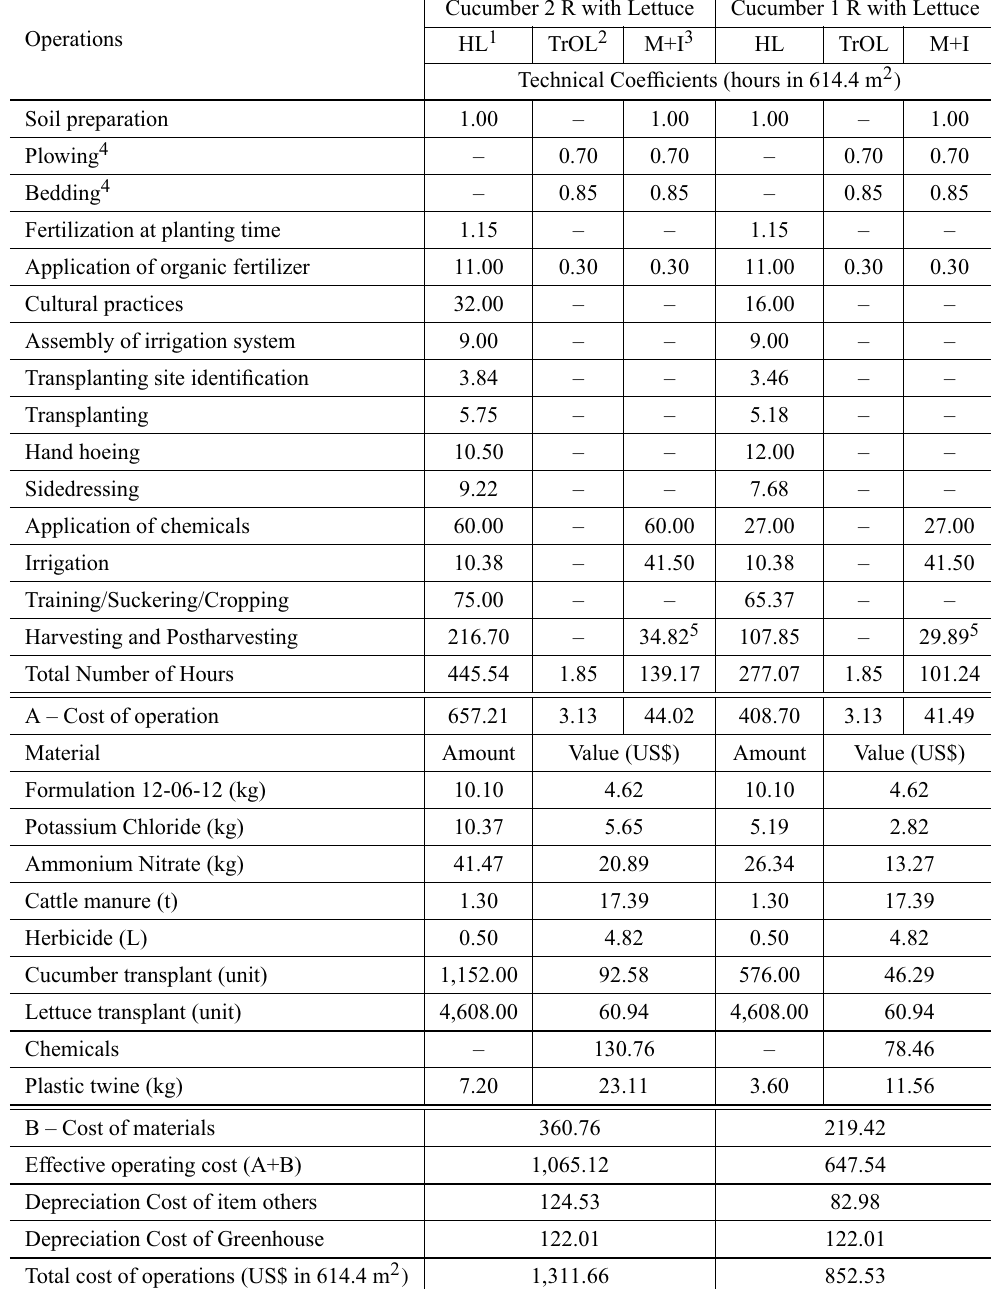
Technical coefficient and total cost of operations in dollars (US$) for August 2007, for the production of Japanese cucumber ‘Hokushin’ cultivated in two (2 R) and one row (1 R) on the bed intercropped with lettuce ‘Verônica’ under greenhouse of 614.4 m 2 . Jaboticabal, SP, Brazil,